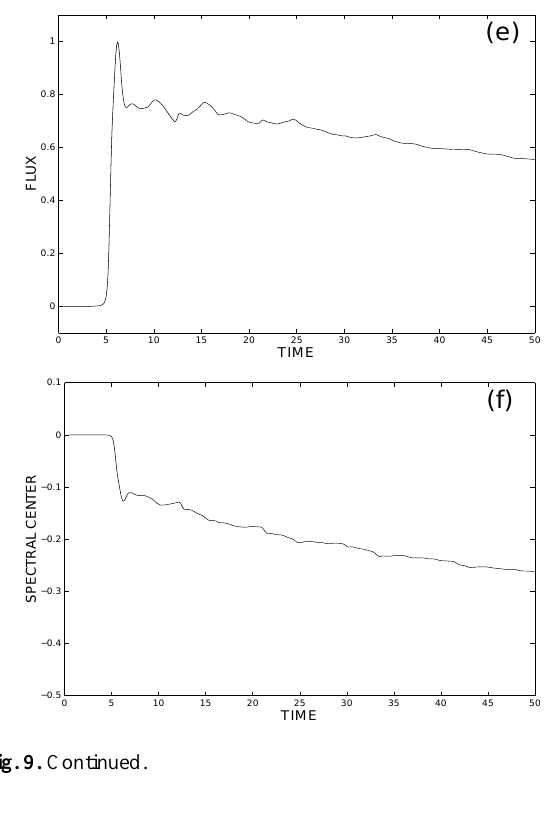
Fig. 9: e-f Nonlinearly damped HONLS eq. ǫ = 0 . 05 , β = 0 . 5 , Γ = 0 : the time evolution of (e) the total energy flux, and (f) the spectral center k m for initial data (17). with 0 . 57 < a < 0 . 67 , µ = 2 π/L , L = 4 √ 2 π . Figure 13 shows, as a function of β : a) the final value of the spectral center k m , b) the maximum strength max , c) the t [0 , 200] S ( t ) ∈